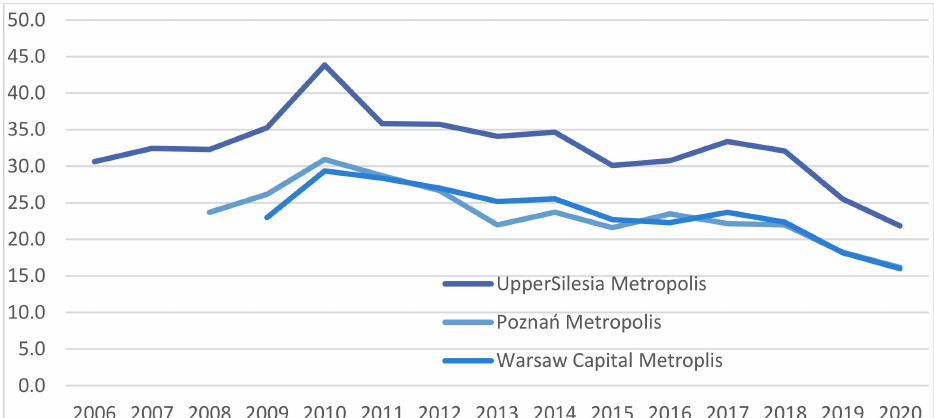
Figure 9. The results of PM 2.5 measurements in three metropolises in Poland in the period from 2003 to 2020. Source: Own elaboration based on measurements